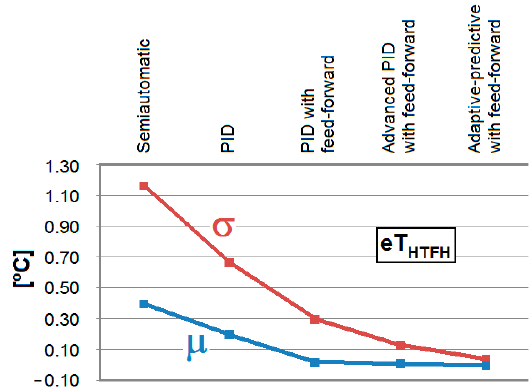
Figure 10. Graphic representation of the simulation results.